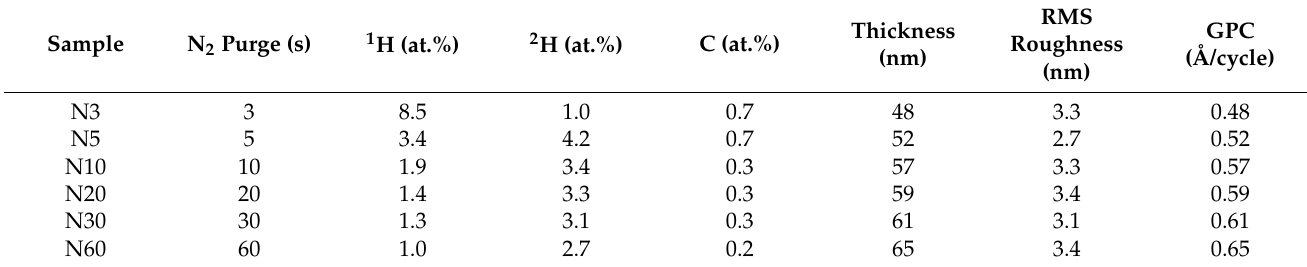
Table 2. The main results of the ZnO samples deposited at 60 ◦ C with varying purging times. The precursor pulse times were kept at 150 ms and 500 ms for DEZ and 2 H 2 O,